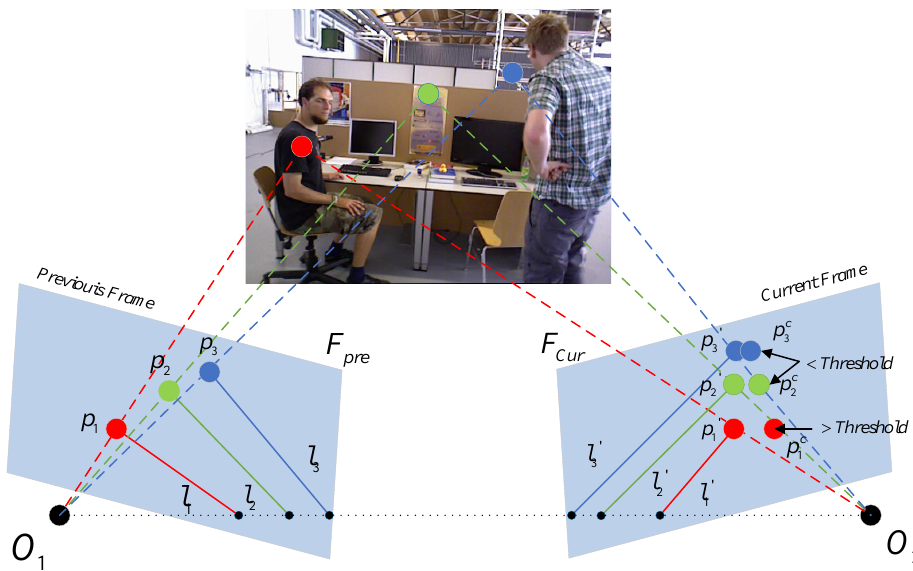
Figure 2. The schematic diagram of dynamic point checking, the left diagram indicates the previous frame and the right diagram indicates the current frame. The specific algorithm flow is shown in Algorithm